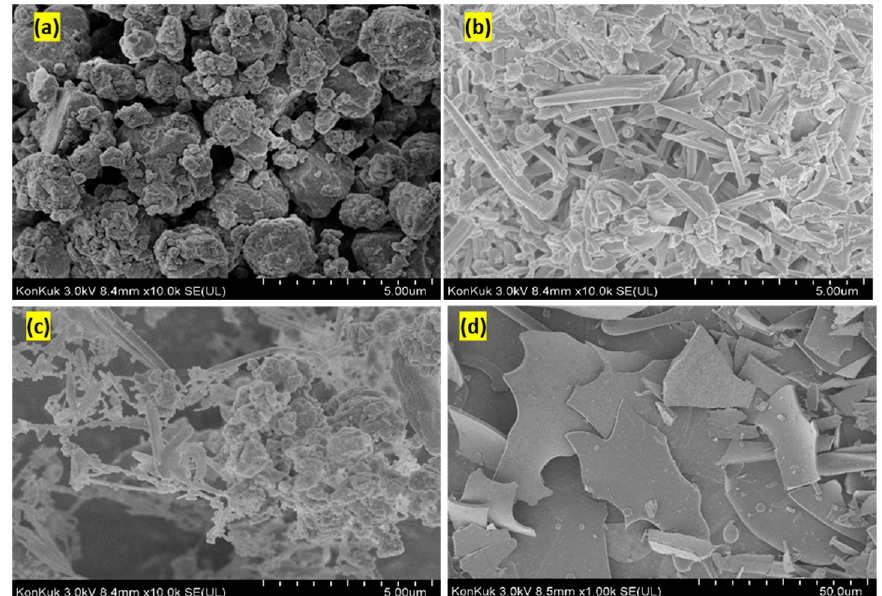
Figure 8. Scanning electron micrographs of ( a ) PdLn@Et- β -CD, ( b ) 1-bromo-4-nitrobenzene (BN), ( c ) their physical mixture, and ( d ) inclusion complex.